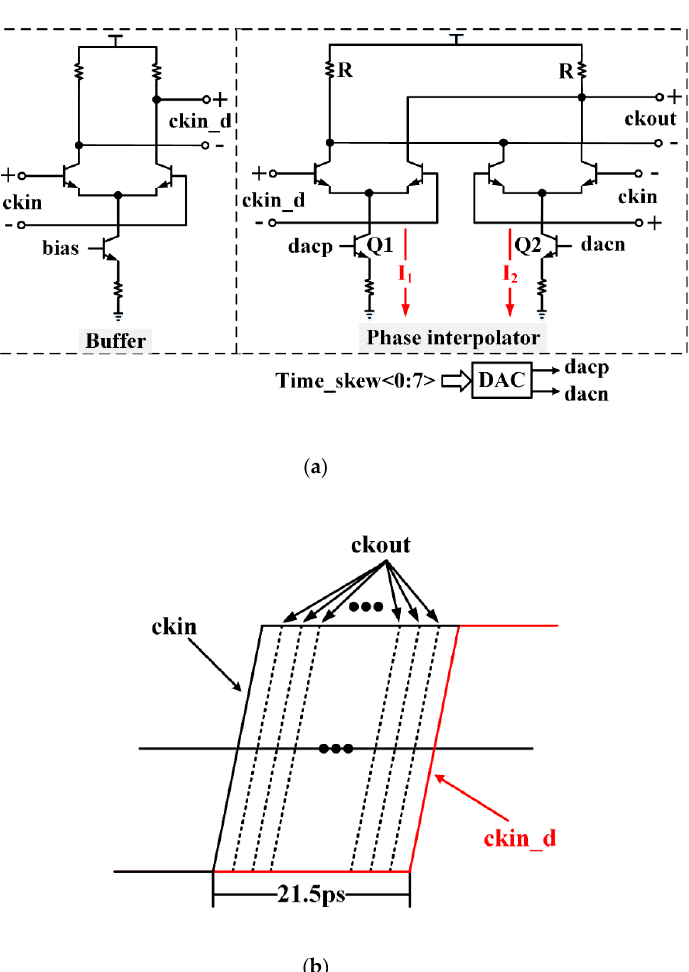
Figure 11. ( a ) Variable delay cell for time skew calibration; ( b ) The diagram of phase interpolating.